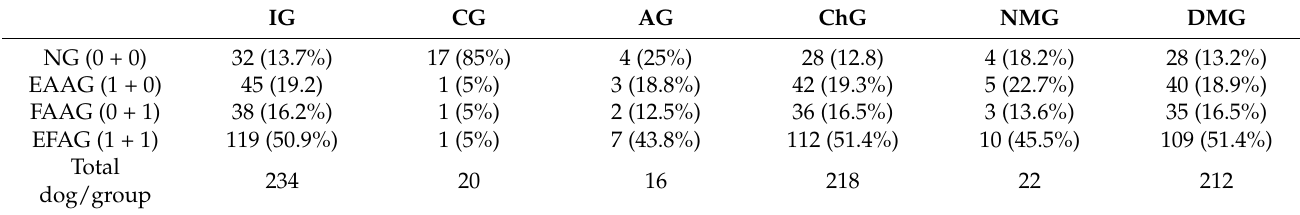
Figure 2. The chart shows the scores (0–4) of the flexion angle in combination with extension angle. Count: number of stifles. Table 3. Percentage of score combinations of the normal and abnormal angles in the various